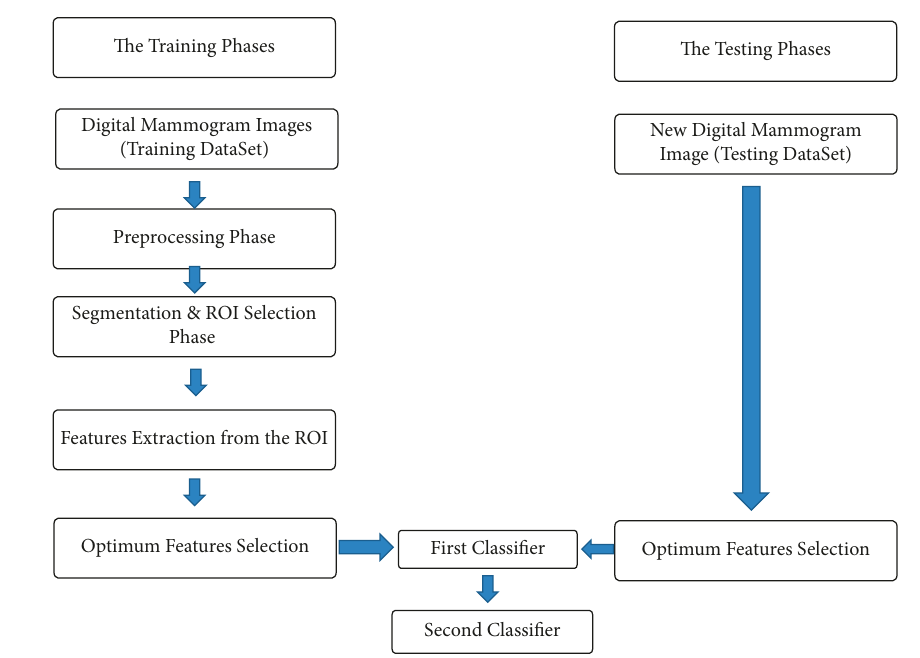
Figure 11: The training and testing phases following the